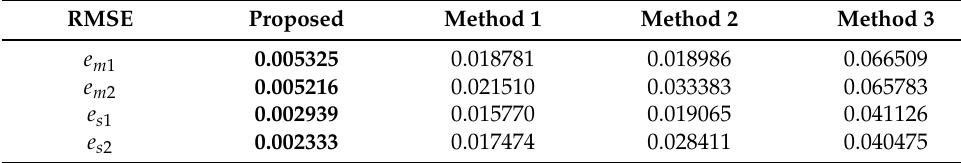
Table 1. RMSE of position tracking errors with different control methods. RMSE Proposed Method 1 Method 2 Method 3 e m 1 0.005325 0.018781 0.018986